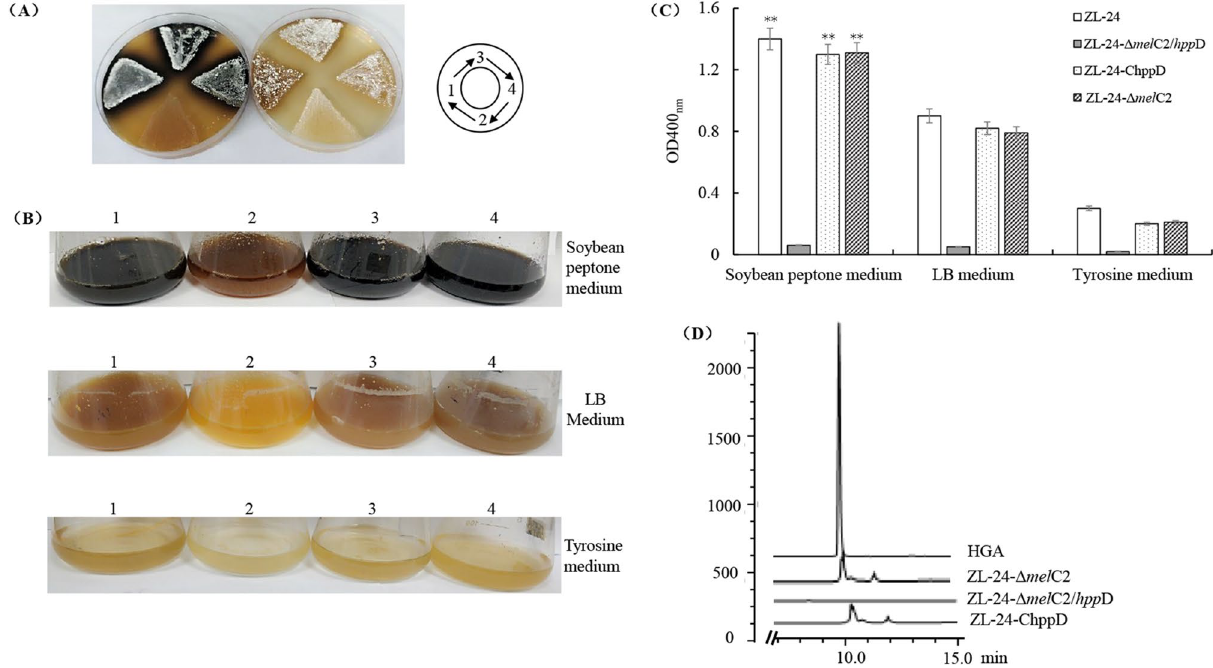
Figure 4. Characteristics of melanogenesis in wild-type ZL-24 (1), double deletion mutant ZL-24- Δ mel C2/ hpp D (2), complementary strain ZL-24-ChppD (3), and ZL-24-Δ mel C2 (4). ( A ) Photographs of cultures at 60 h in culture on soybean peptone plate (left) and LB plate (right). ( B ) Photographs of cultures at 60 h in culture in soybean peptone medium (top), LB medium (middle), and tyrosine medium (bottom). ( C ) The melanin yield, as determined by OD400 nm , after 60 h in culture in soybean peptone, LB and tyrosine media. Data are presented as mean ± standard deviation of three independent experiments. ** p ≈ 0.004 < 0.01 is determined using one-way ANOVA and Dunnett post hoc test. (D) HPLC profiles of the cell free culture supernatant from ZL-24, ZL-24-Δ mel C2/ hpp D, ZL-24-Δ mel C2, and ZL-24-ChppD at 6 h in culture in soybean peptone medium, HGA is used as a